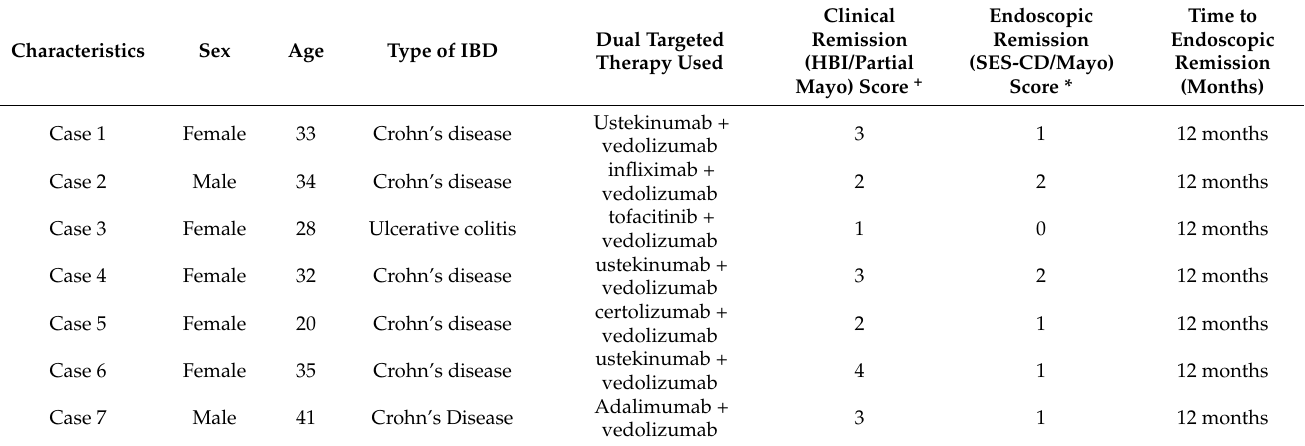
Table 1. Summary of Patients’ Characteristics and Dual Targeted Therapy